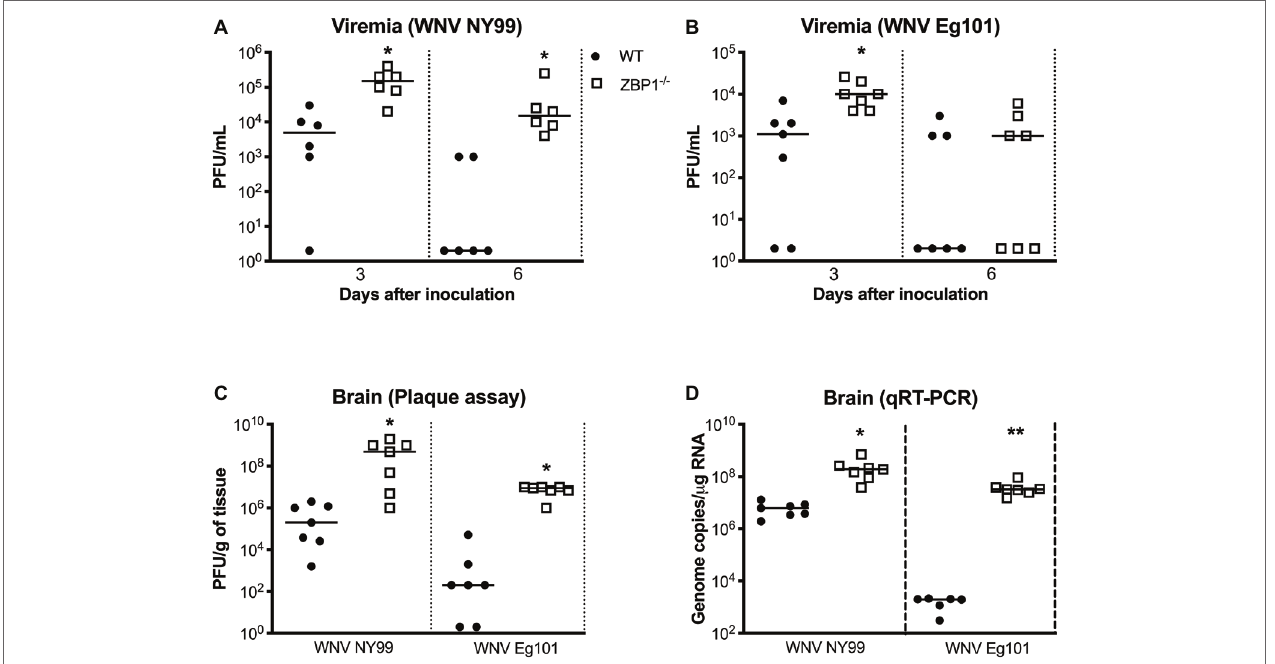
FIGURE 2 | Analysis of virus titers in WT and ZBP1 −/− mice. Virus titers were measured in the serum at days 3 and 6 after (A) WNV NY99 or (B) WNV Eg101 infection by plaque assay and expressed as PFU/mL. (C) Virus titers were measured in brain homogenates (day 8 after infection with WNV NY99 or WNV Eg101) and expressed as PFU/g of tissue. (D) The WNV RNA copy number in the brain was determined by qRT-PCR and expressed as genome copies/μg of RNA (day 8 after infection with WNV NY99 or WNV Eg101). Each data point represents an individual mouse. The solid horizontal lines signify the median ( n = 6–7 mice per group). * p < 0.05, ** p <